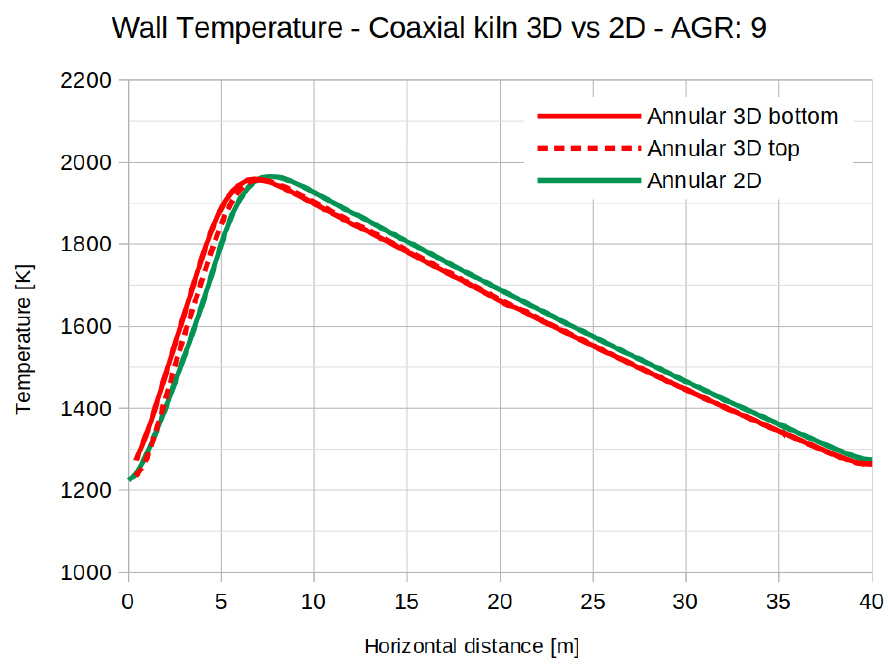
Figure 10. Computed top and bottom wall temperature along the axis of the kiln, 2D (green) vs. 3D (red). AFR: